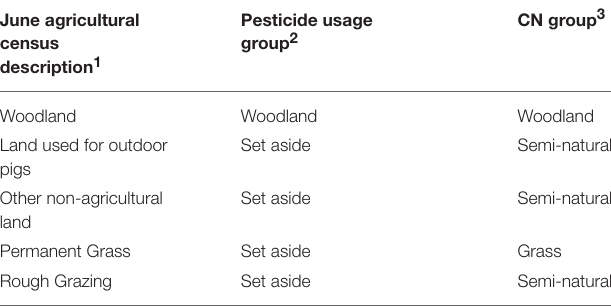
TABLE 3 | Pesticide usage and Curve Number (CN) groups for different land use